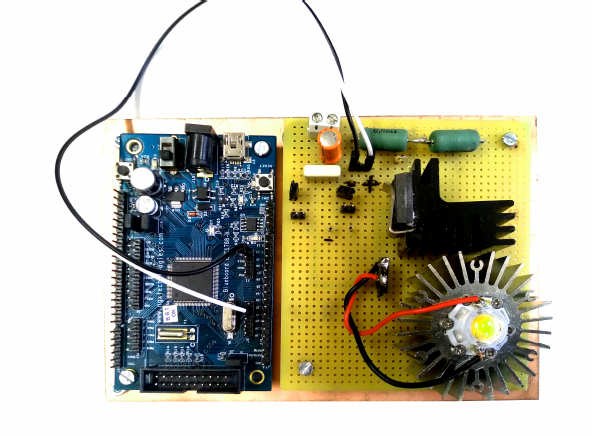
Figure 19. One of the emitters used in the experimental